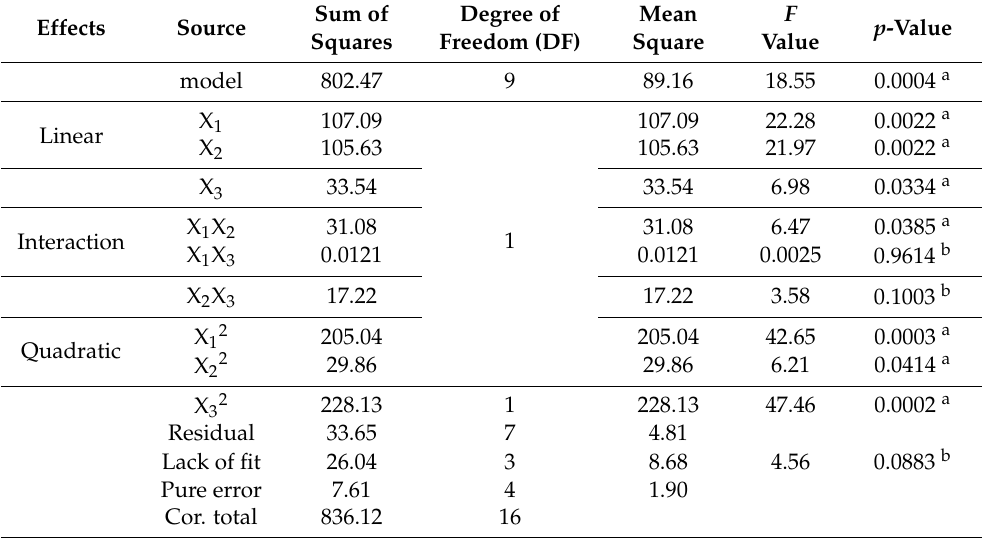
Table 5. Results of ANOVA